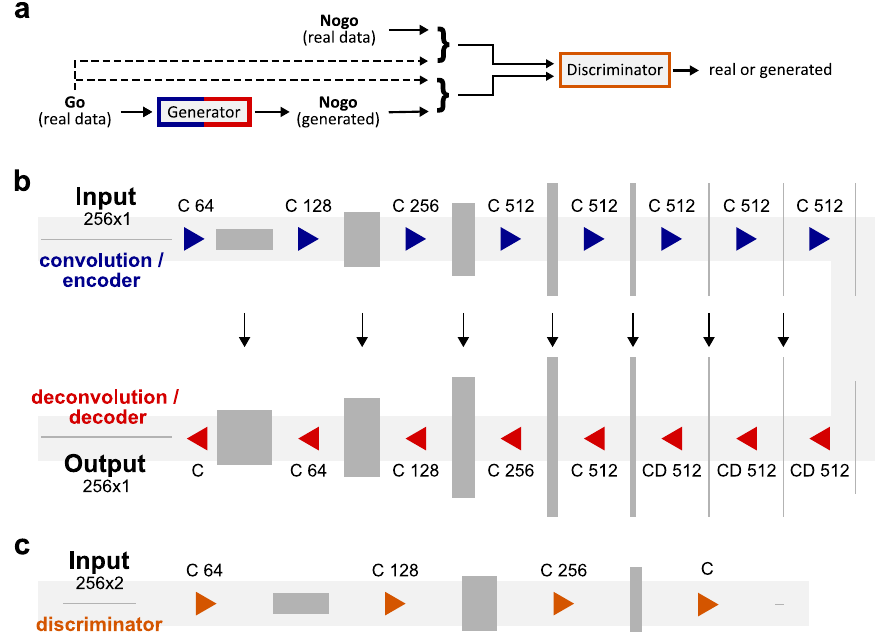
Fig. 5 The general procedures and architectures of the conditional GAN for generating a Nogo signal based on the Go signal. a General procedures for generating a Nogo signal based on the Go signal. The real Go signal is fed into the generator. The real Go signal is concatenated with real and generated Nogo data separately. The discriminator assesses whether the pair of either real Go/real Nogo data or real Go/generated Nogo data is real or fake. b The architecture of the generator. It consists of an encoder (i.e., blue part) and a decoder (i.e., red part). Both decoder and encoder each consist of eight convolutional layers. Convolutions in the encoder down-sample by a factor of 2, whereas in the decoder, data is up-sampled by a factor of 2. Black arrows indicate a skip connection between each layer of the encoder and the decoder. c The architecture of the discriminator. It consists of four convolutional